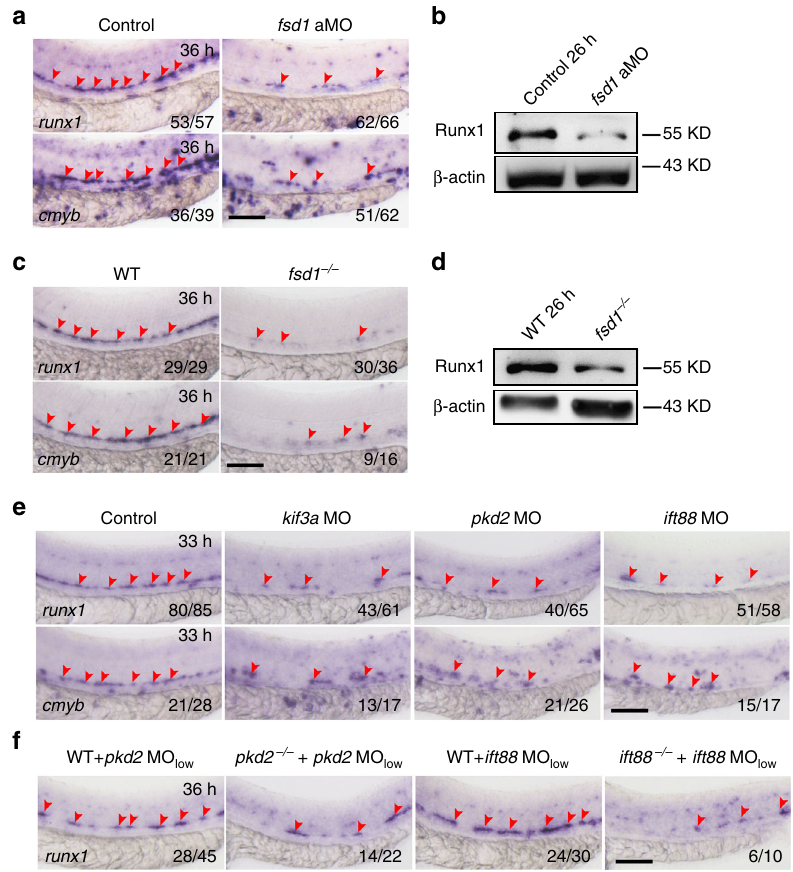
Fig. 3 Loss of cilia genes induces hematopoietic stem and progenitor cell (HSPC) defects. a Whole-mount in situ hybridization (WISH) results of HSPC markers ( runx1 and cmyb ) in the aorta-gonad-mesonephros (AGM) region in control and fsd1 morphants at 36 hpf. The red arrowheads indicate the expression of HSPC markers runx1 and cmyb in DA. b Western blotting showing the protein level of Runx1 in control and fsd1 morphants at 26 hpf. c WISH analysis showing the expression of HSPC markers runx1 and cmyb (red arrowheads) in the DA in fsd1 − / − . d Western blotting showing the protein level of Runx1 in fsd1 − / − . e Representative images showing runx1 and cmyb expression in control, pkd2 , kif3a , and ift88 morphants at 33 hpf. The red arrowheads indicate the expression of HSPC markers runx1 and cmyb . f WISH analysis showing the expression of HSPC marker runx1 in the DA in pkd2 − / − or ift88 − / − with a sub-effective dose of pkd2 MO (0.5 ng per embryo, pkd2 MO low ) or ift88 MO (0.8 ng per embryo, ift88 MO low ). The red arrowheads indicate the expression of HSPC marker runx1 . Scale bars, 100 µ